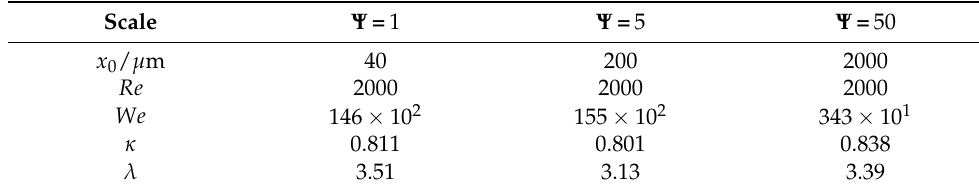
Table 5. Resulting dimensionless numbers of the droplet breakup for all three scales based on a Reynolds number Re = 2000 in the disruption unit and droplets with a diameter x 0 of 40, 200 and 2000 µ m, respectively.